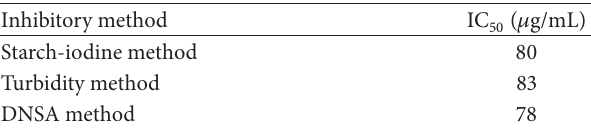
Table 3: Acarbose positive control for 𝛼 -amylase inhibitory